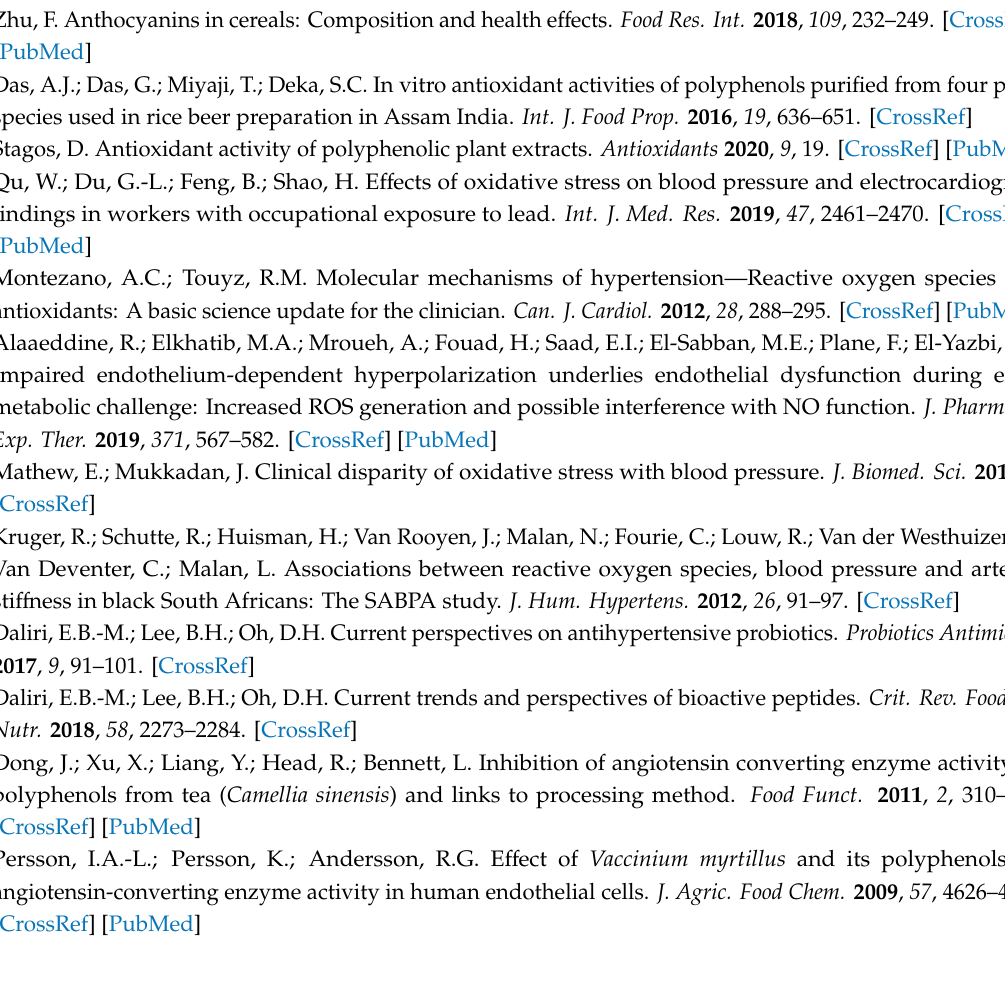
Table S1: Procedure for assay of ACE activity. Table S2: Organic acids and volatile compounds in destarched rice, Prozyme treated destarched rice (DP) and fermented DP. Table S3: Amino acids in destarched rice, Prozyme treated destarched rice (DP) and fermented DP. Table S4: Phenolic compounds in destarched rice, Prozyme treated destarched rice (DP) and fermented